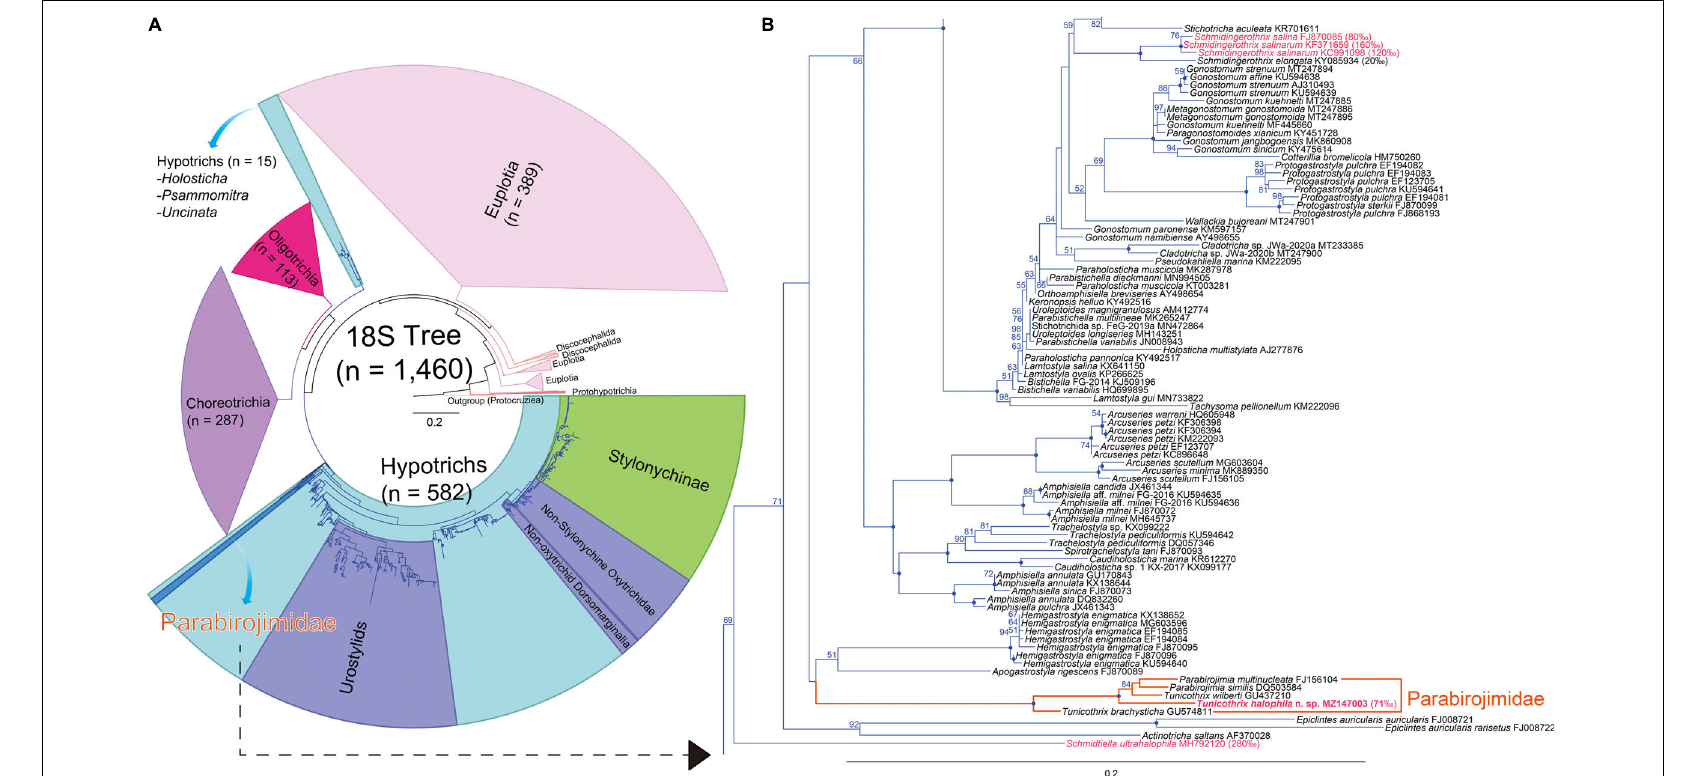
FIGURE 6 | Maximum likelihood (ML) phylogenetic tree inferred from the 18S rRNA gene sequences (A,B) . (A) Complete tree comprising 1,460 sequences. (B) The clades containing the family Parabirojimidae and other halophile hypotrichs. Bootstrap values are shown near nodes, values ≤ 50% were not shown, dots at nodes represent 100 bootstrap value. Newly obtained sequence is in bold. Species from hypersaline habitats are in pink color. The scale bar represents 20 nucleotide substitutions per 100